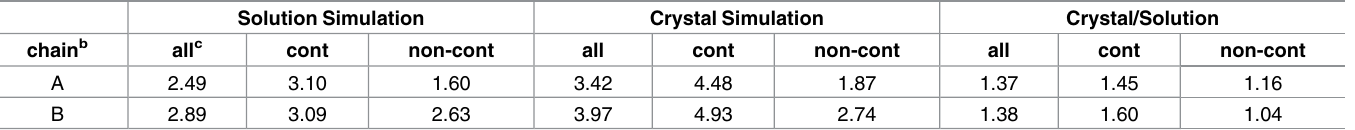
Table 1. Likelihood ratios for sampling X-ray rotamers in solution and crystal simulation a